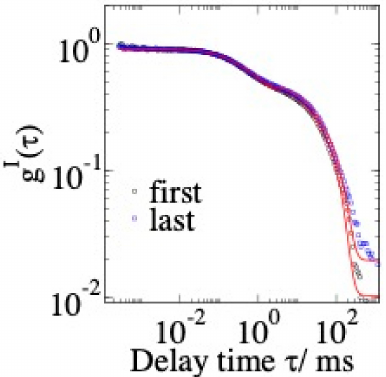
Figure 10. The electrical field first-order correlation functions of the first and the last DLS measure- ments performed on the apomyoglobin sample during the neutron beam time. Although larger structures were permanently present in the sample, the two curves nearly coincide. This means that the aggregation state of the sample did not change during the long integration time needed for the SANS measurement. The red lines mark the fit to the data using the CONTIN algorithm.